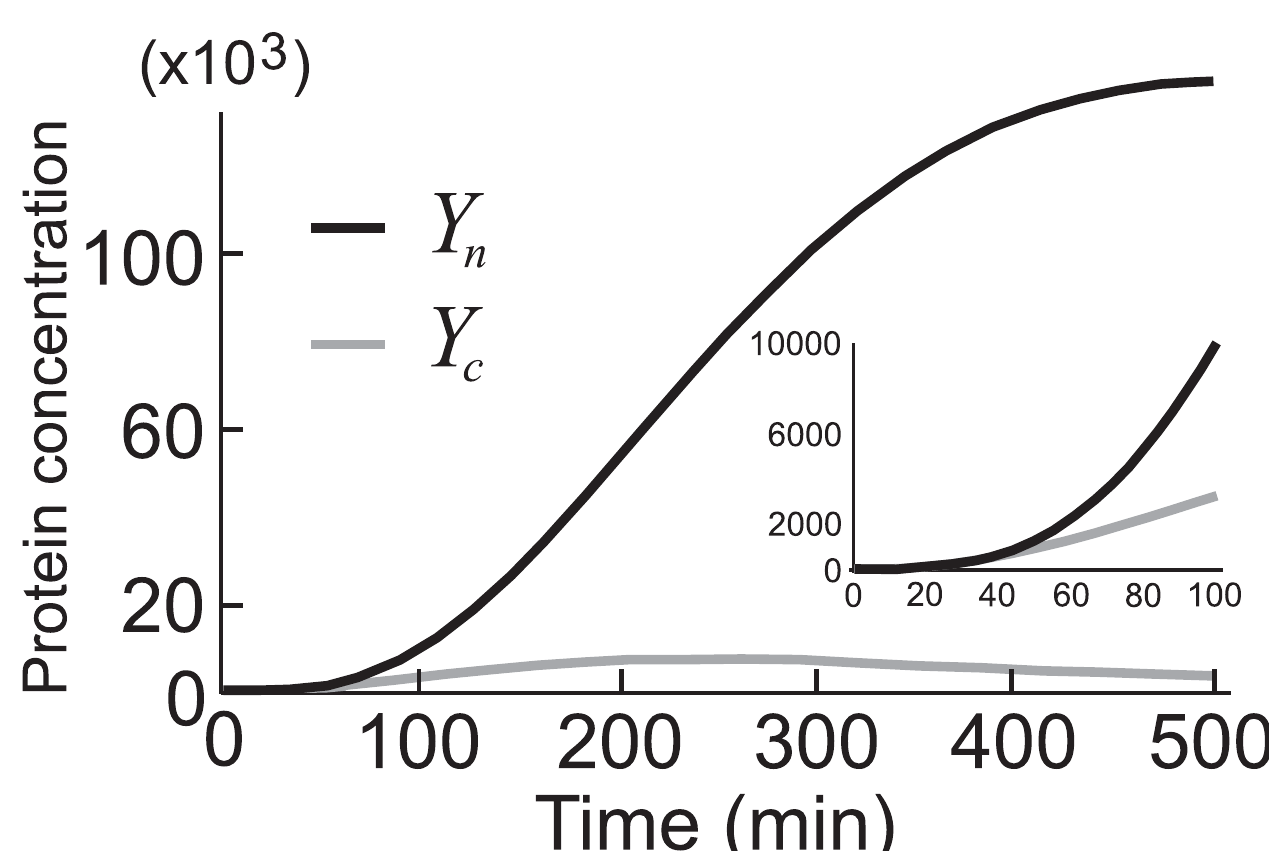
Fig 2. Evolution of average protein concentrations. A close-up view of the figure is given on the right-hand side. The nuclear and the cytoplasmic concentrations rise at approximately the same rate until t (cid:3) 40, after which time the nuclear concentration begins to increase much more rapidly.